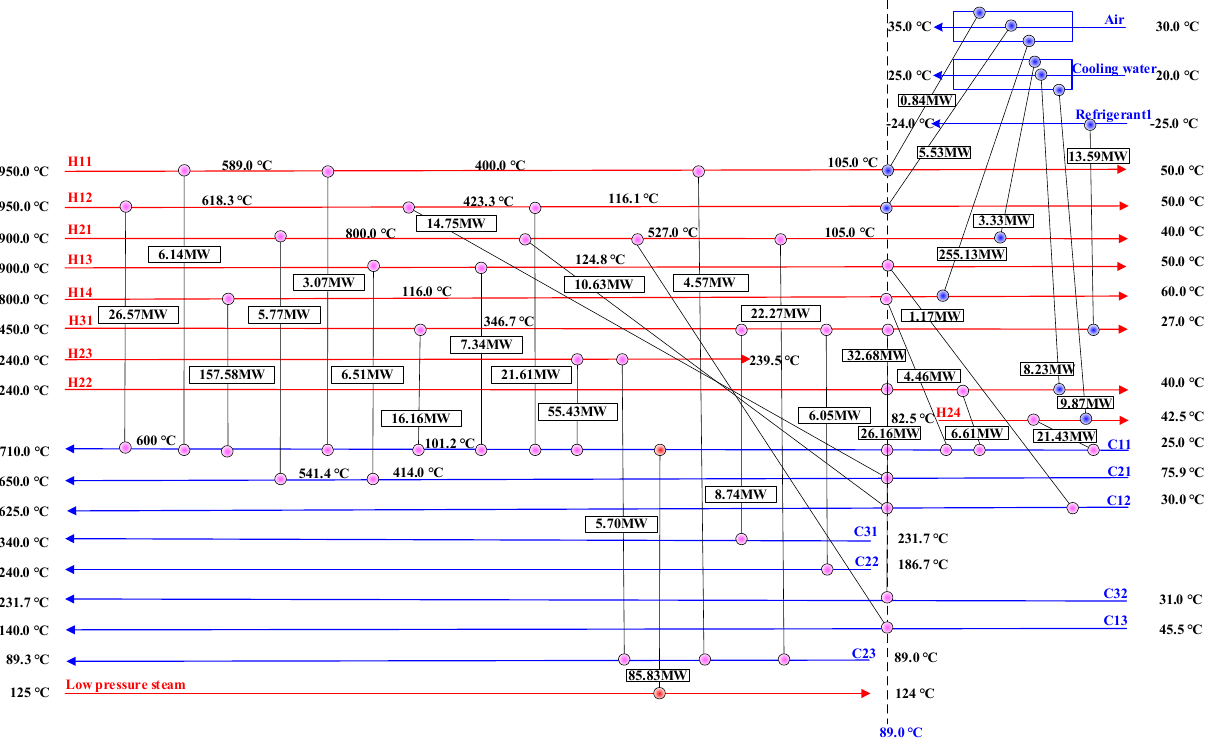
Figure 9. Grid diagram of HEN for the system.